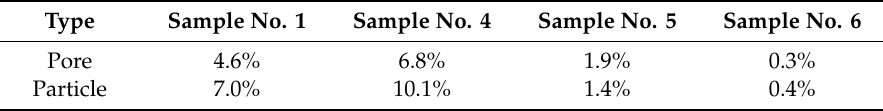
Table 4. Pore and particle area ratio for SEM by Image J.